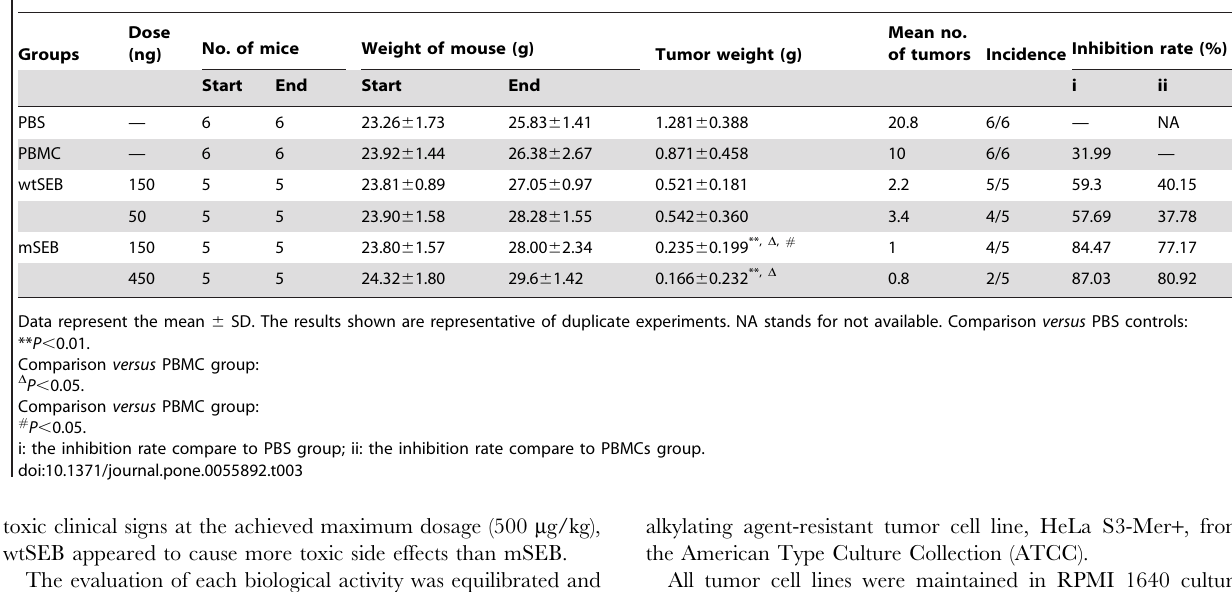
Table 3. Inhibition of tumor growth by mSEB in xenografted NOD/SCID mice.